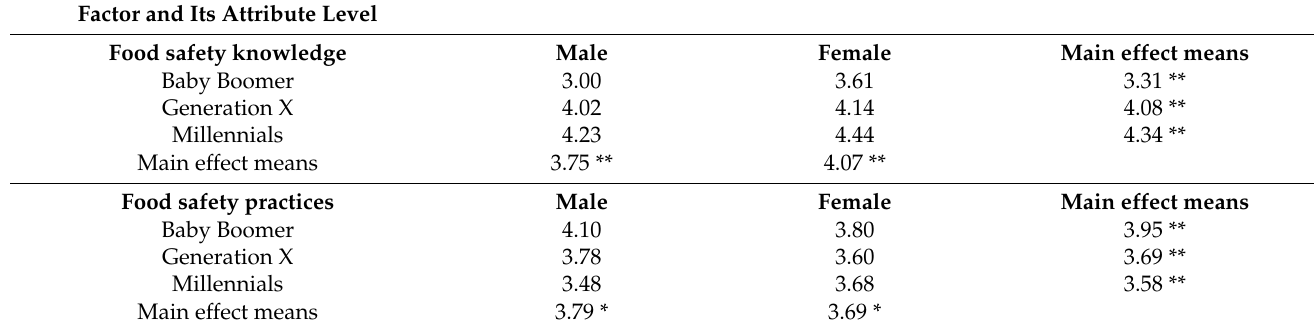
Table 5. Main effect of food safety knowledge and food safety